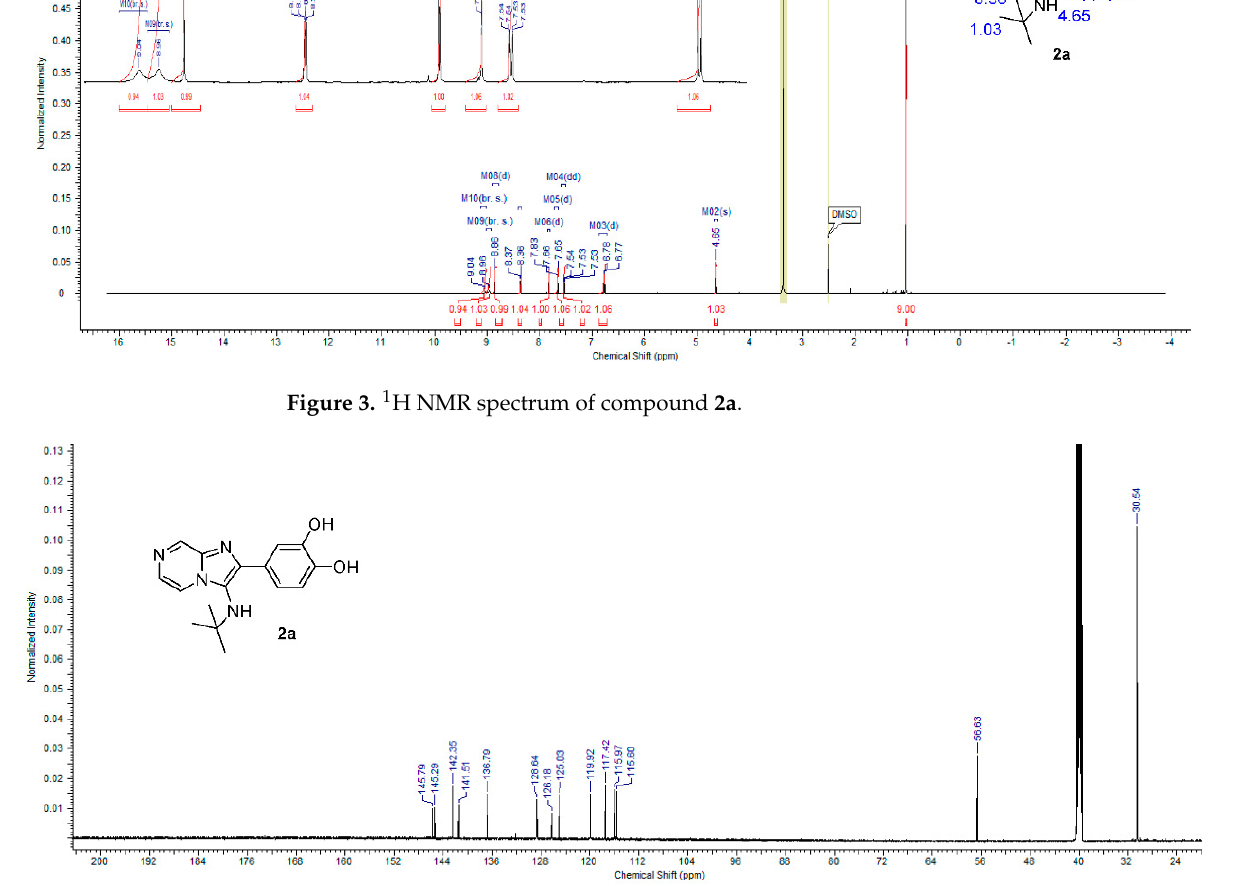
Figure 4. 13 C NMR spectrum of compound 2a.